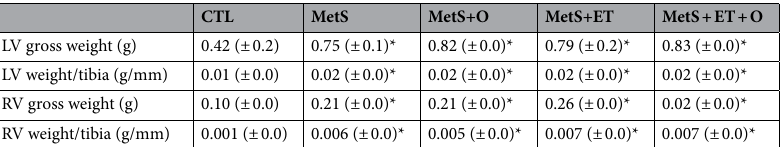
Table 2. Weight of the heart chambers CTL–Control. MetS–Metabolic Syndrome. MetS+O–Metabolic Syndrome and Okra. MetS+ET–Metabolic Syndrome and Exercise Training. MeTS+ET+O–Metabolic Syndrome and Exercise Training and Okra. * Different of CTL. p ≤ 0.05.